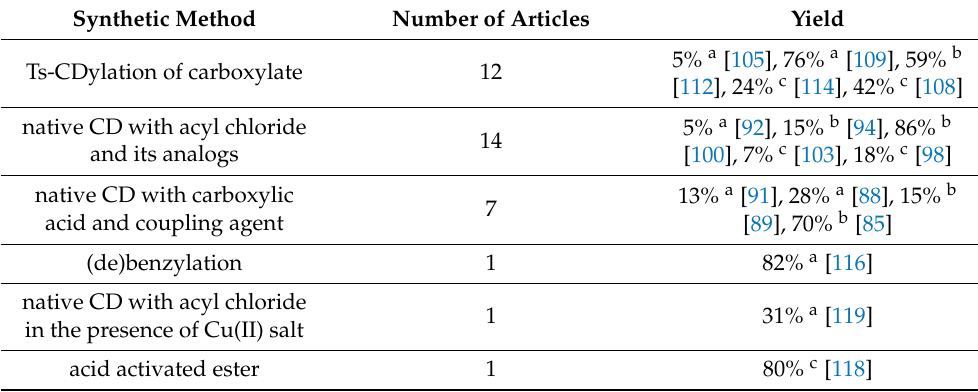
Table 4. Preparation of 6 A - O -acyls of